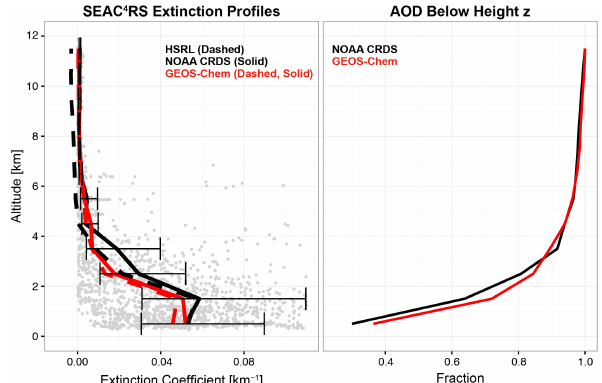
Figure 8. Median vertical profiles of aerosol extinction coefficients (532nm) over the southeast US during SEAC 4 RS. The left panel shows independent observations from the NASA HSRL and NOAA CRDS instruments, with GEOS-Chem sampled at the times and lo- cations of the available instrument data. The individual CRDS ob- servations are shown in gray and the horizontal bars denote the 25th and 75th percentiles of the CRDS observations for each 1 km bin. The choice of scale truncates some very large individual observa- tions. The right panel shows the observed (CRDS) and simulated Figure 7. Extent of neutralization of sulfate aerosol in the southeast fraction of the total AOD below a given height. The southeast US US (August–September 2013). The extent of neutralization for an domain is as defined in Fig. external sulfate-nitrate-ammonium (SNA) mixture is given by the f = [NH + ] / (2[SO 2 − ] + [NO − ]) molar ratio, and this can be ad- 4 4 3 justed for an internal mixture by considering additional ions. The top panels show observations from the CSN network, assuming an external (left) or internal (right) mixture; there is little difference between the two because the concentrations of additional ions are usually small. The bottom panels show the SEAC 4 RS aircraft ob- servations below 2km and the corresponding GEOS-Chem values. Also shown are the lines corresponding to different extents of neu- tralization ( f = 0.5 for ammonium bisulfate and f = 1 for ammo- nium sulfate).